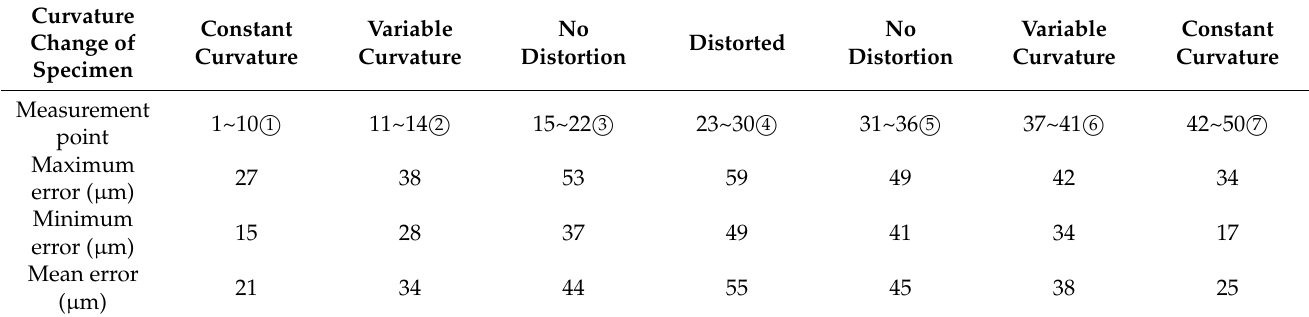
Table 3. Comprehensive error data distribution of specimens with 15 ◦ inclined plane